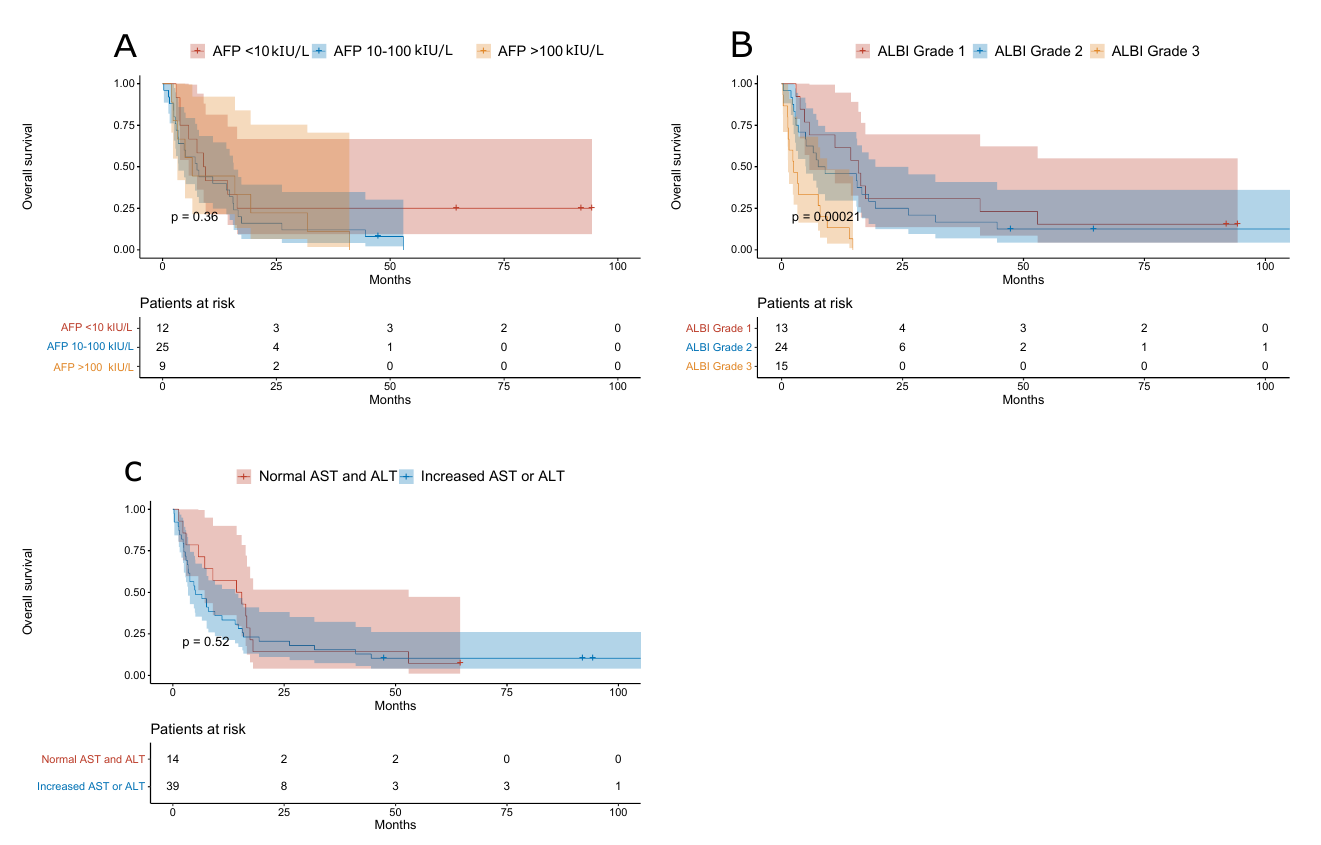
Figure 7. ( A ) Overall survival of NAFLD-related HCC patients stratified by the baseline AFP value (cut-off, 10 and 100 kIU/L). ( B ) Overall survival of NAFLD-related HCC patients stratified by ALBI grade. ( C ) Overall survival of NAFLD-related HCC patients with normal and increased serum aminotransferases. Table 4. Factors associated with overall survival in patients with NAFLD-related HCC (after adjusting for BCLC stage). Hazard Ratio (95% p Confidence Interval)